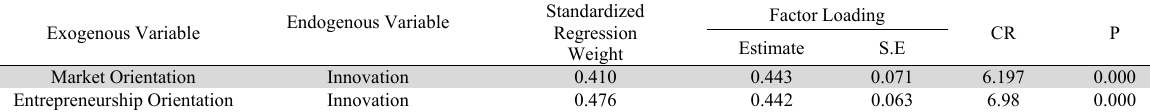
First Hypothesis SEM Test Results. Market orientation and entrepreneurship orientation towards innovation